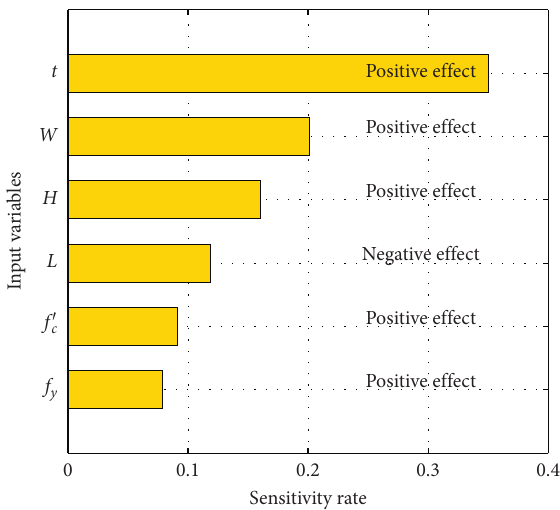
Figure 10: Sensitivity rate of each variable obtained from the ANFIS